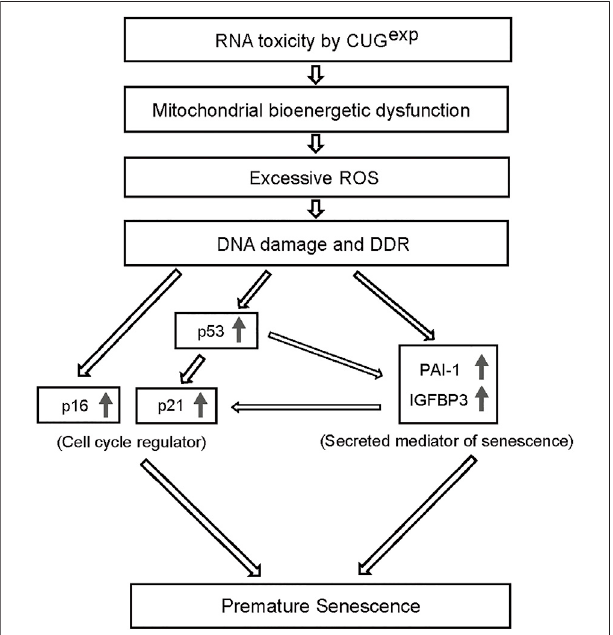
FIGURE6| Proposed mechanism ofprematuresenescence byCUG exp RNA expression. RNA toxicity by CUG exp causes mitochondrial dysfunction, which contributes to ROS overproduction, triggering DNA damage and DDR. Accumulated DNA damage activates cell cycle regulators, such as p53, p21, and p16. ROS-induced DNA damage upregulates the secreted mediators PAI-1 and IGFBP3 in a p53-dependent and -independent manner, which drive premature senescence. These multiple steps in the process of senescence interact with one another, inducing premature